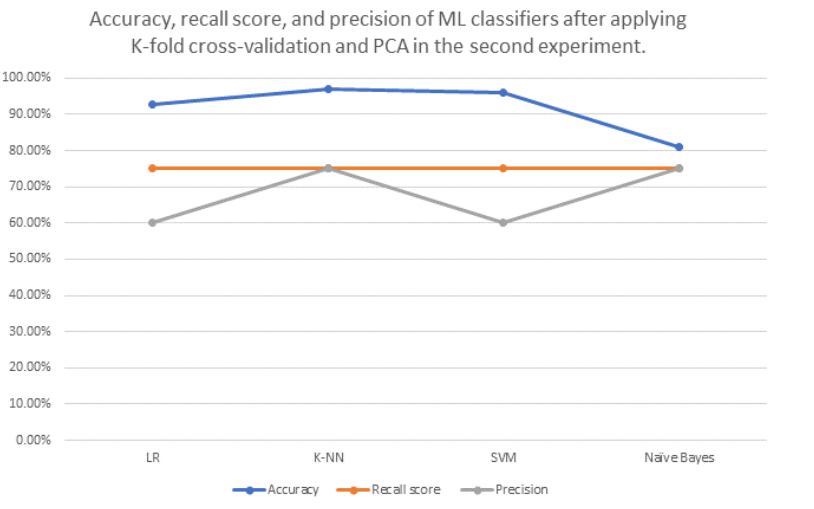
Figure 9. Accuracy, recall score, and precision of ML classifiers after applying K-fold cross-validation and PCA in the second